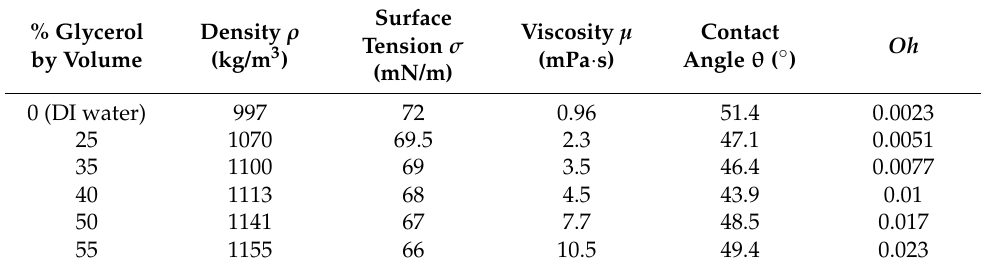
Table 1. Measured fluid properties of glycerol–water solutions used for